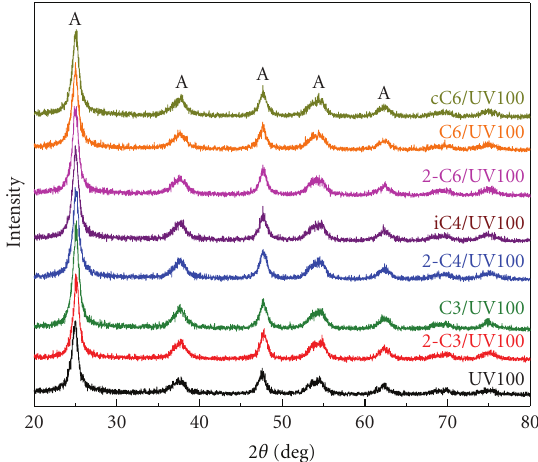
Figure 5: XRD patterns of the